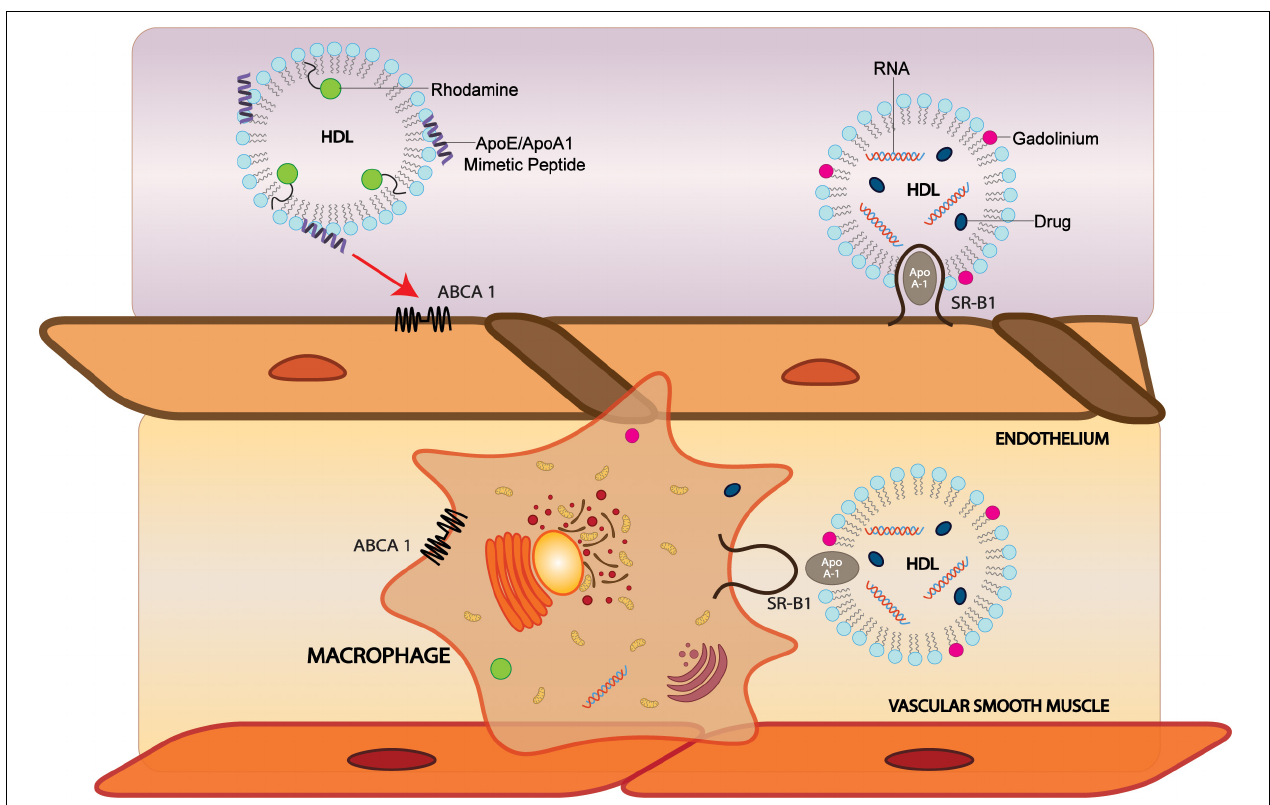
FIGURE 2 | Modification of sHDL particles can facilitate brain, vascular cell, and macrophage delivery. HDL-like NPs labeled with phospholipid-containing dyes such as rhodamine and probes conjugated with CS-6253, an ABCA1 agonist, can target ABCA1 on endothelial cells and macrophages to deliver cargo. Incorporation of MRI contrast agents such as gadolinium into HDL can increase signal. In SR-BI positive cells, sHDLs comprised of apoA-I can bind SR-BI and are taken up by the cell where cargo is delivered. ABCA1, ATP Binding Cassette Subfamily A Member 1; SR-BI, Scavenger receptor, class B type